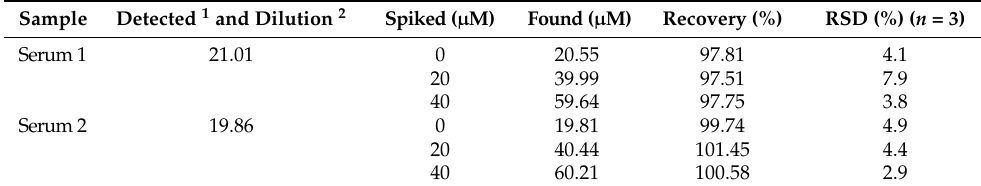
Table 1. Results of measurement of cholesterol in serum.